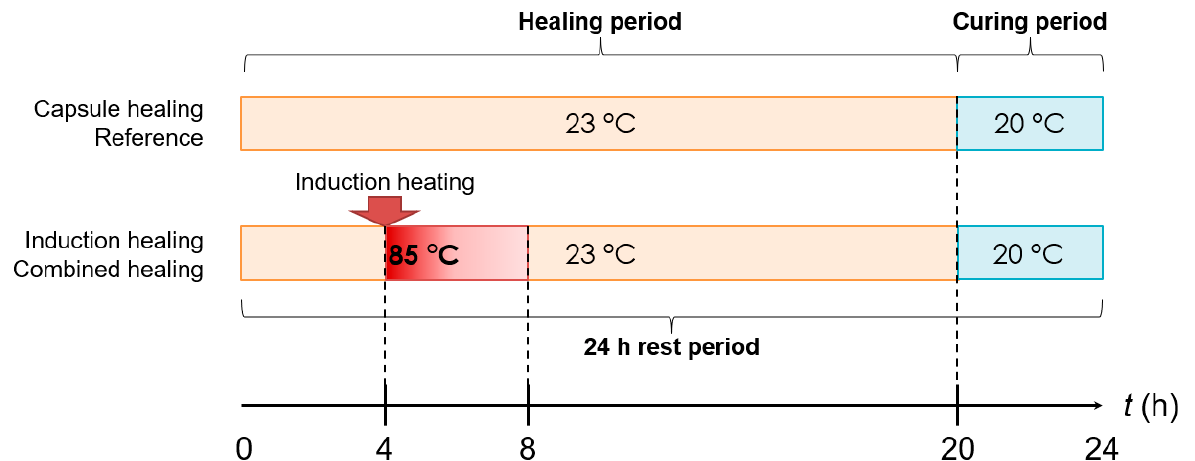
Figure 9. 24-h rest period for the healing of various healing systems.